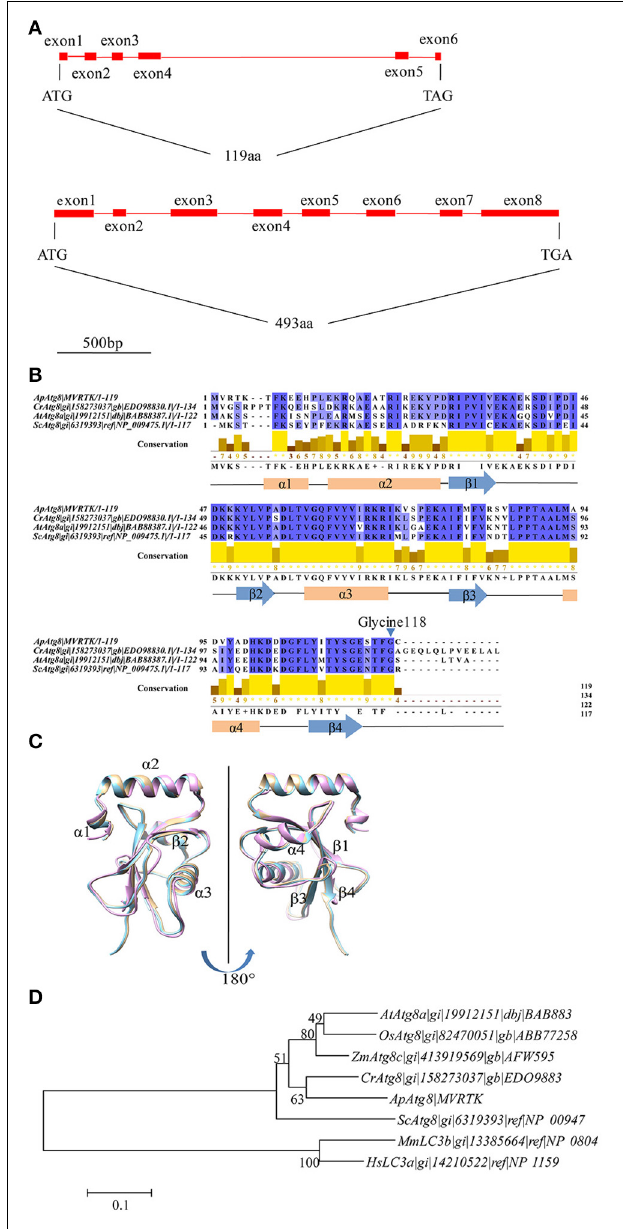
FIGURE 2 | Identification of ApATG8 and ApATG4 . (A) Genomic structure of ApATG8 (top panel) and ApATG4 (bottom panel). Filled boxes indicate exons and straight lines represent introns. (B) Multiple sequence alignment of Atg8 proteins. Conservation indexes are shown as yellow numbers. A conserved C-terminal glycine residue at position 118 is indicated with an arrowhead. Cr , Chlamydomonas reinhardtii ; Ap , Auxenochlorella protothecoides ; At , Arabidopsis thaliana ; Sc , Saccharomyces cerevisiae . (C) Overlay of the tertiary structures of ApAtg8 (wheat), yeast Atg8 (cyan), and human LC3 (pink). (D) Unrooted phylogenic tree of Atg8 proteins constructed using the Neighbor-Joining method. The branch numbers on the nodes indicate the bootstrapping values. At , Arabidopsis thaliana ; Os , Oryza sativa ; Zm , Zea mays ; Cr , Chlamydomonas reinhardtii ; Ap , Auxenochlorella protothecoides ; Sc, Saccharomyces cerevisiae ; Mm , Musmusculus ; Hs , Homo sapiens